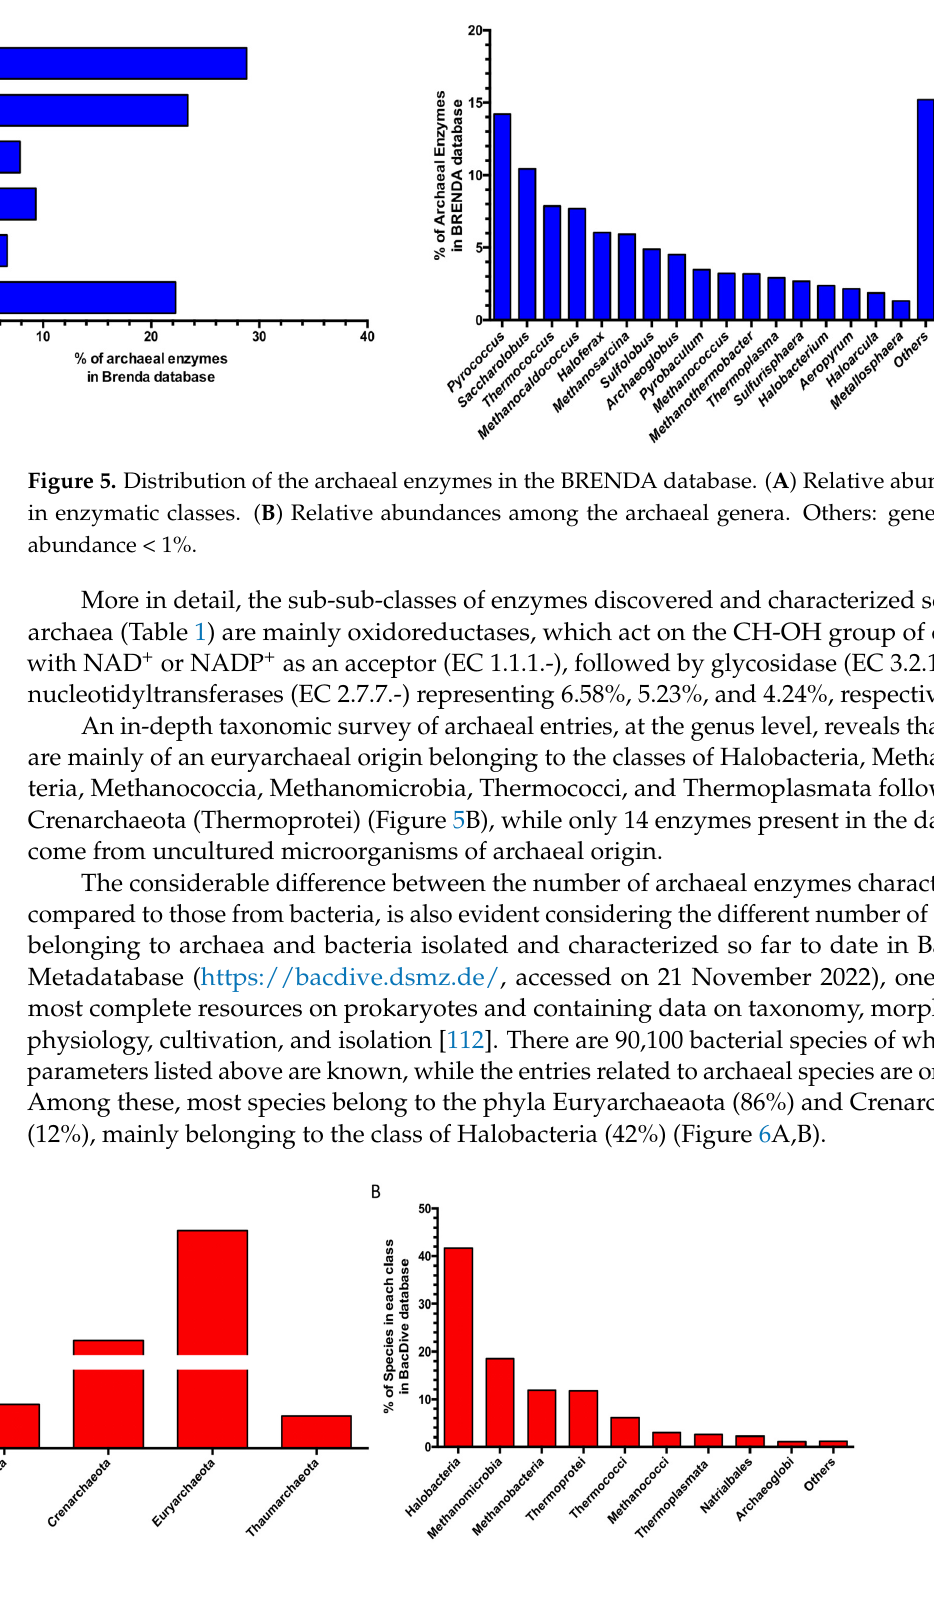
Figure 7. Schematic flowcharts of enzyme discovery approaches. The culture-dependent approaches can be summarized in (i) Genomic discovery, and (ii) Microbial activity discovery. These approaches are frequently applied in parallel and bound to the possibility of isolating and growing in the laboratory the microbial strains that will serve as the source of the appropriate enzymatic activity. For what it concerns Genomic discovery, access to the genome sequence is sufficient. The genomes functionally annotated by bioinformatic analysis allow for the identification of genes encoding for putative enzymes that through recombinant expression can be ob- tained and subsequently characterized [115]. This approach has allowed for the